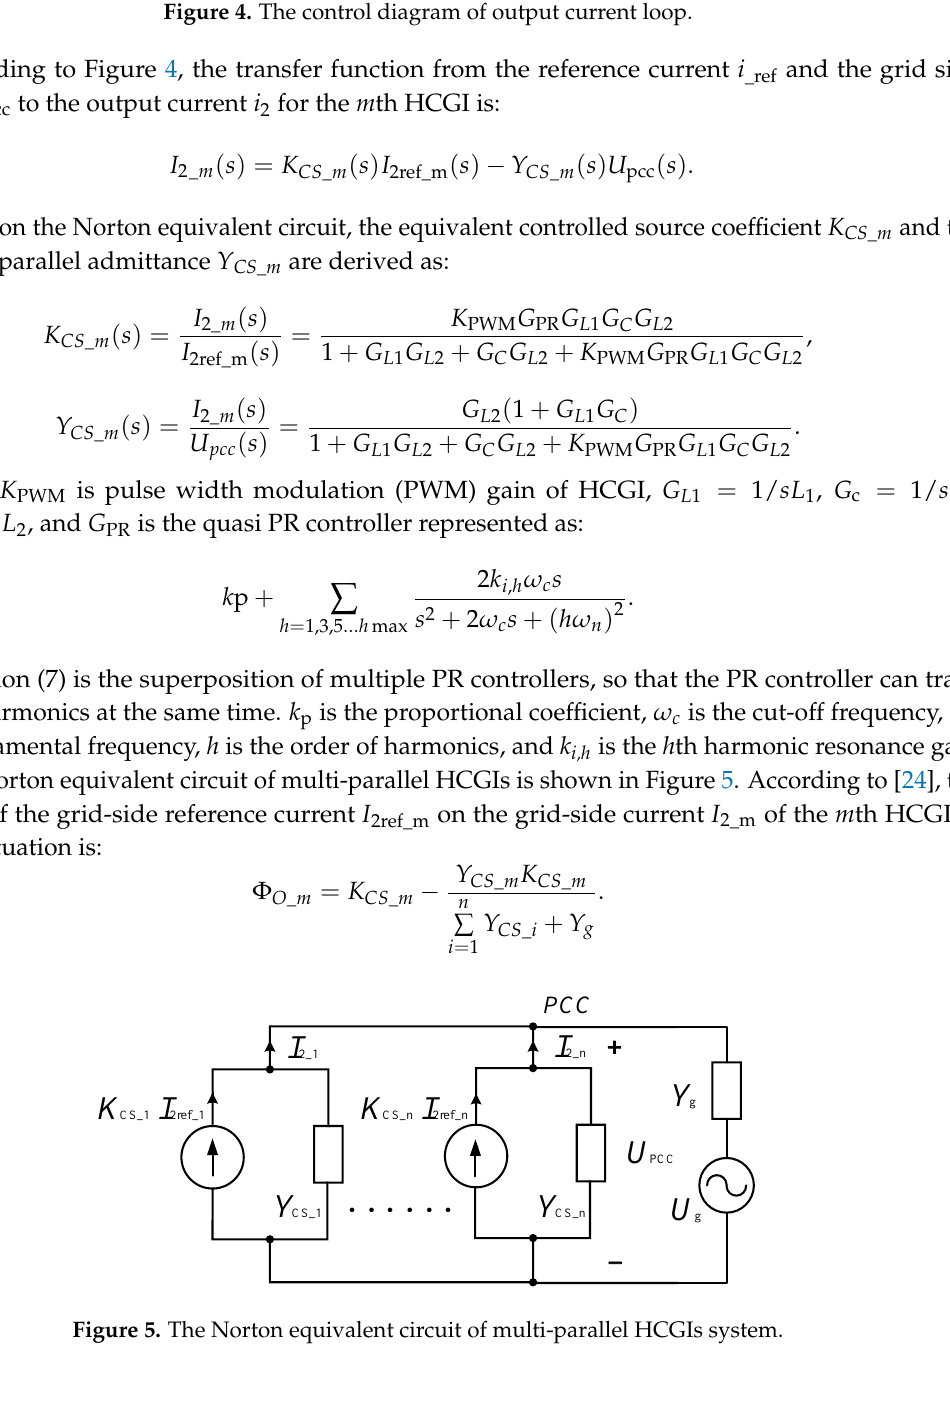
Figure 4. The control diagram of output current loop.